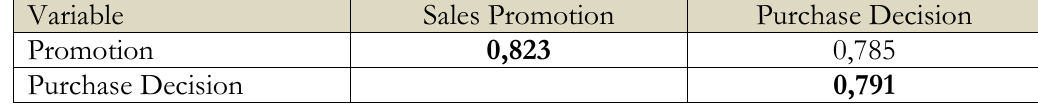
Table 4. Discriminant Validity (Fornell-Lacker Criterion) Test